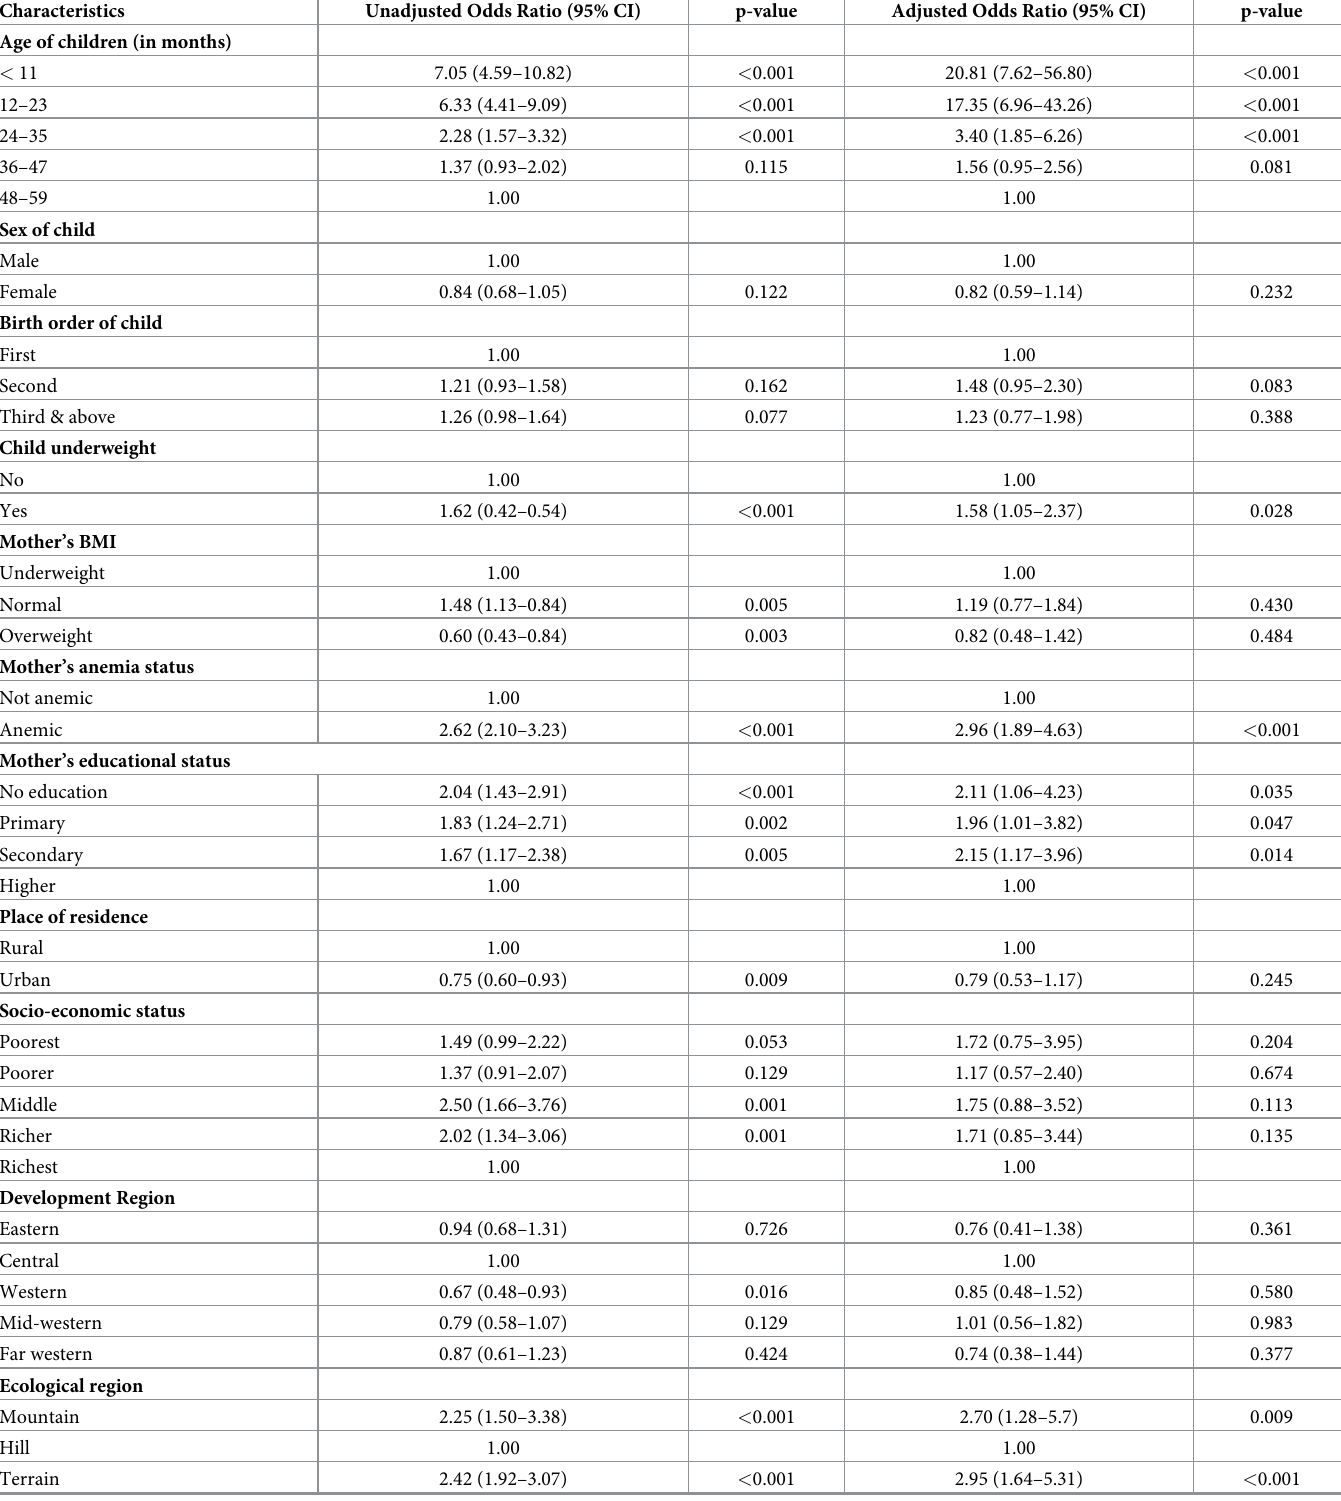
Table 3. Determinants of moderate-to-severe anemia among children under 5 years old.